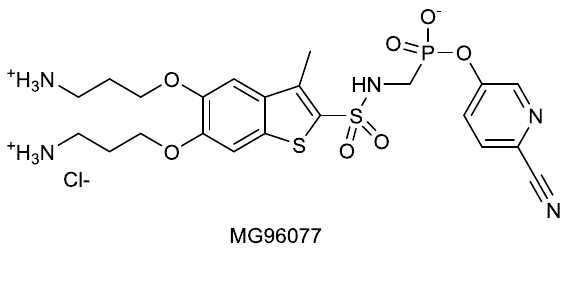
Figure 20. Chemical structure of phosponate β-lactamase